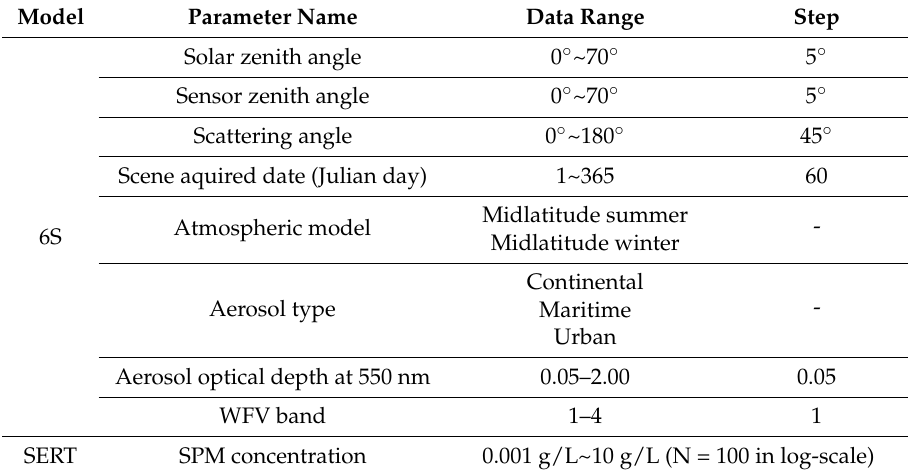
Table 4. Input parameters for 6S and SERT model and their varied range in this